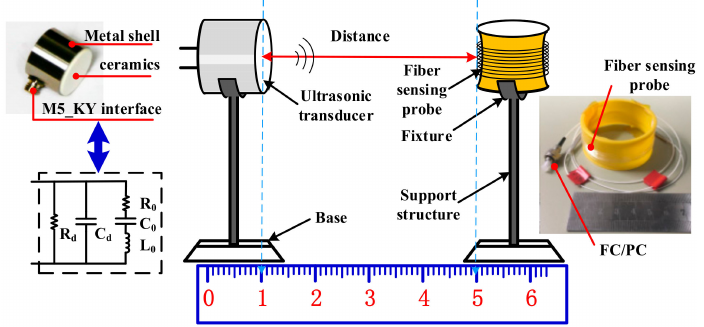
Figure 4. Experimental setup and diagram for the detection of piezoelectric ultrasonic